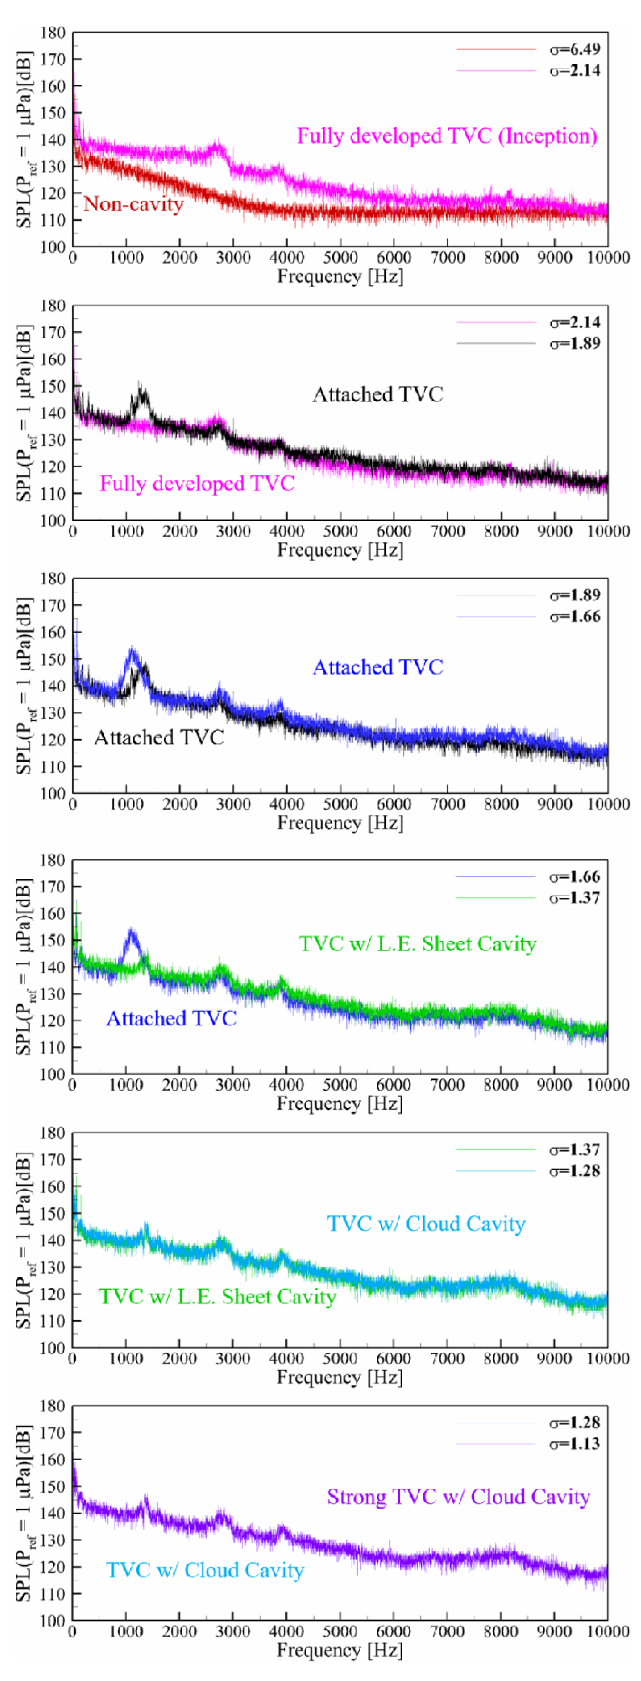
Figure 9. Induced noise characteristics of NACA 66(2)-415 hydrofoil at α = 8 ◦